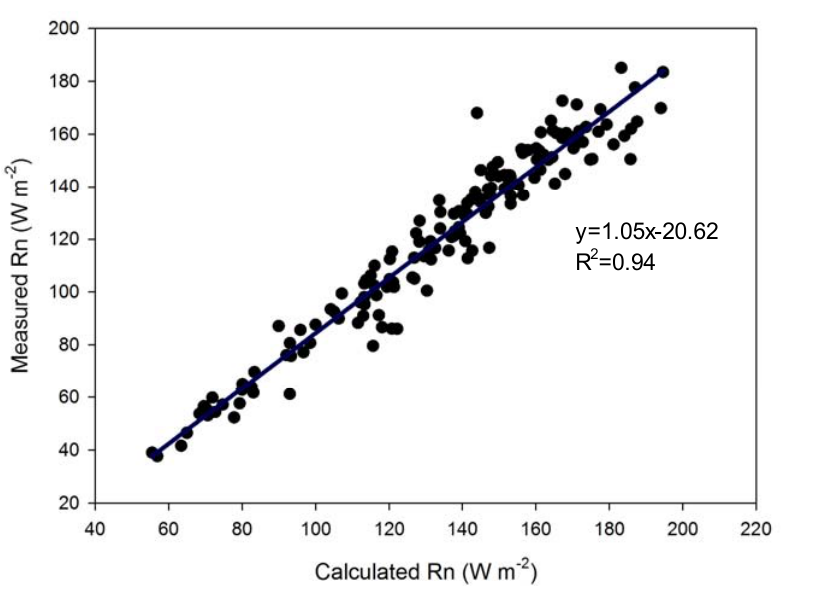
Figure 2. Comparison of daily calculated and observed net radiation at Lethbridge during the growing seasons of 1991 to